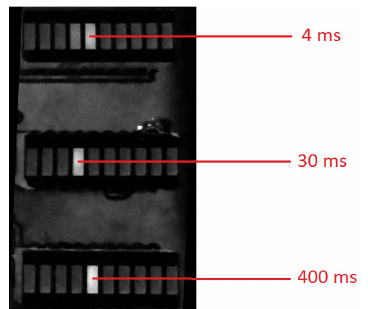
Figure 2. The determination of camera lag using LED bar- graphs.